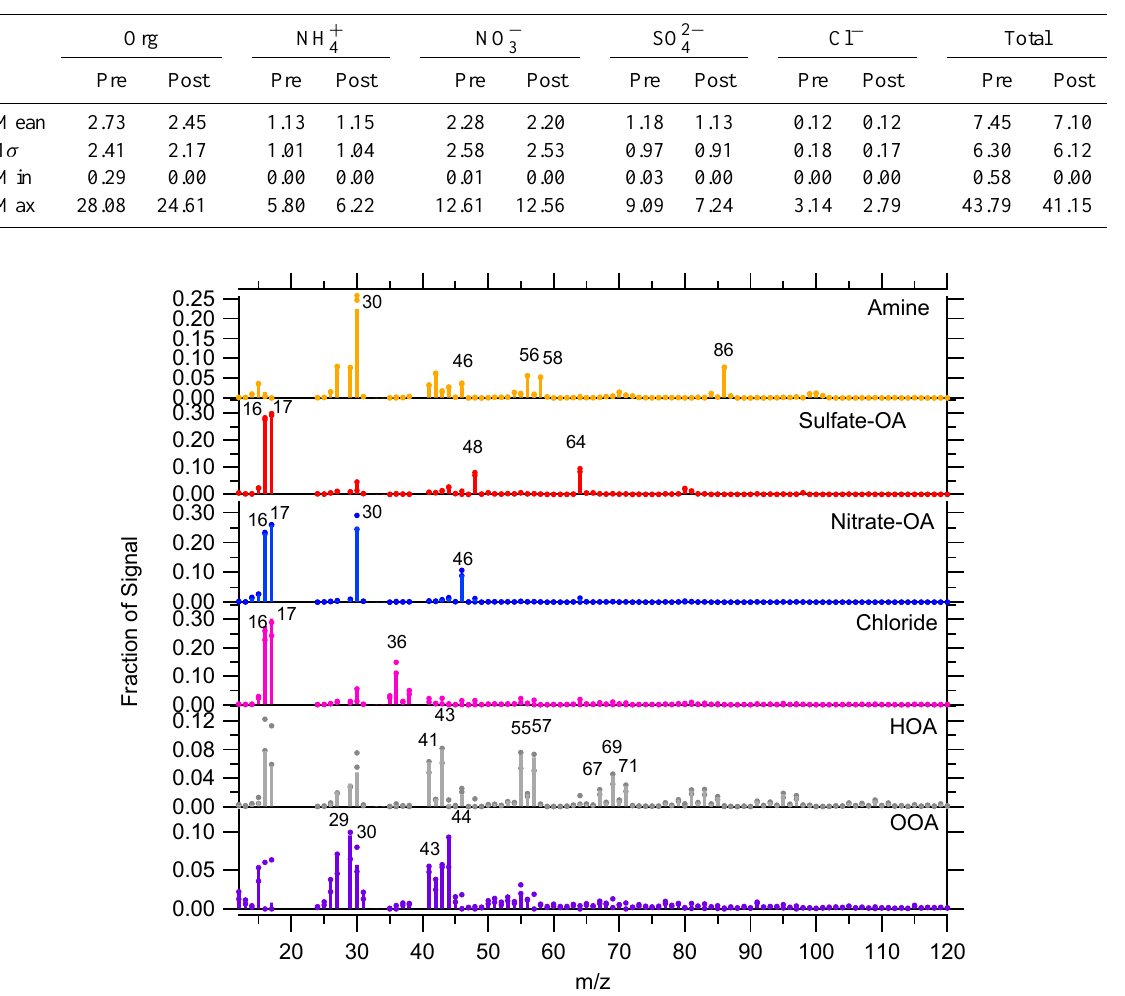
Table 1. Descriptive statistics for AMS-measured non-refractory sub-micron PM species, pre- and post-PMF analysis (µgm − 3 ).